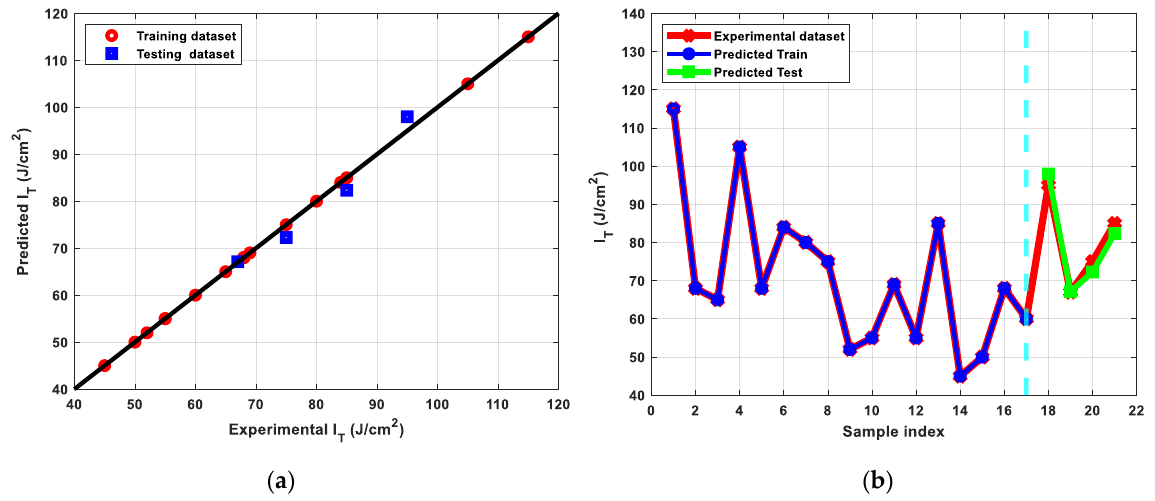
Figure 13. ( a ) Predicted versus experimental I T evaluated for the training and the testing sets, ( b ) Predicted I T versus sample index plotted for predicted train, predicted test, and experimental I T . Table 5. Evaluation metrics of I T machine learning models for both the training and testing sets. Training Set Testing Set